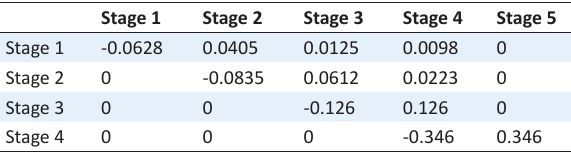
Table 4 . Estimated transition intensities for misclassification model